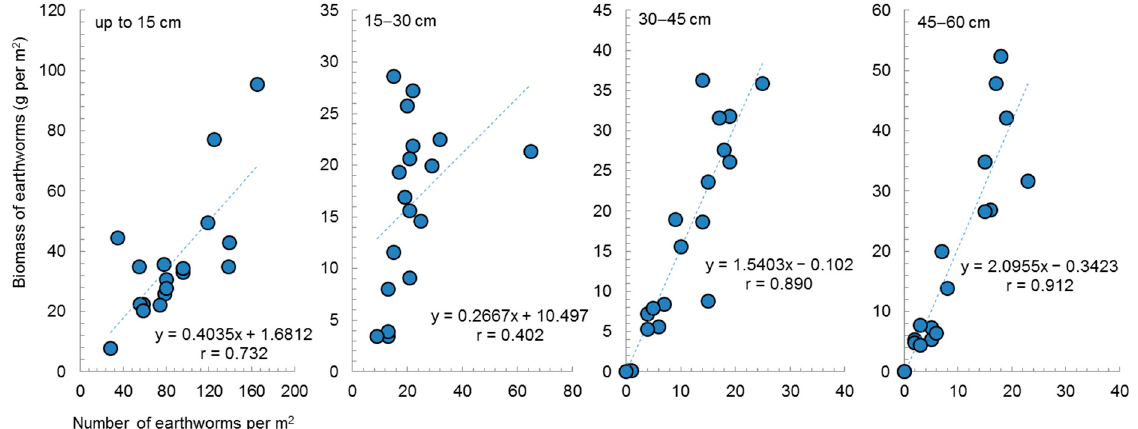
Figure 6. Relationship between mean biomass and number of earthworms per m 2 at different soil depths (in all depths p = 0.001, except 15–30 cm p = 0.038) according to different soil management practices in vineyard; r—Pearson correlation index.